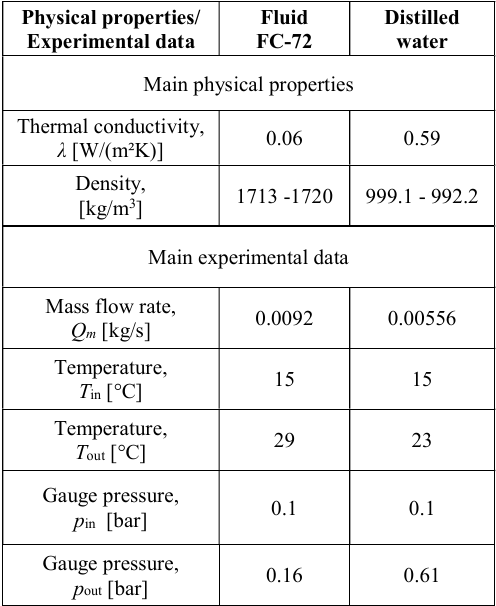
Fig. 5 . View of the mesh of the layers of the test module, Simcenter STAR-CCM+.